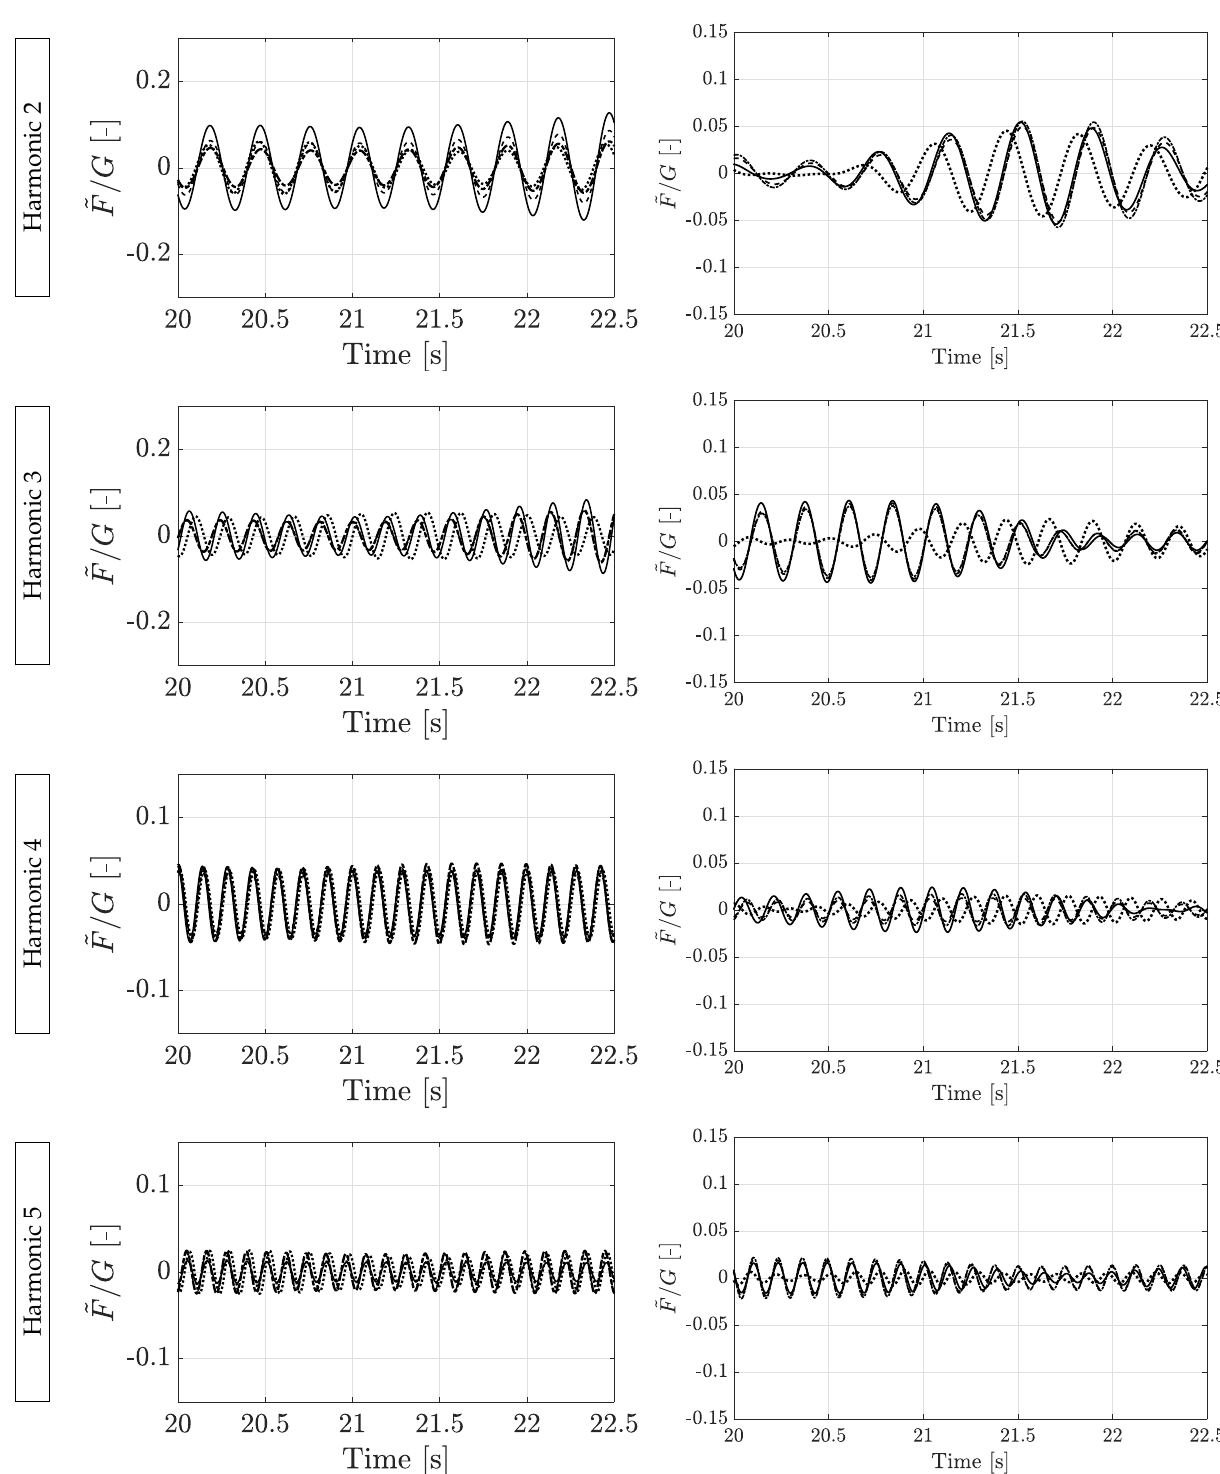
Figure 12. Relevant zoom of the time series of the contact force of the reference trial for the different harmonic components: measured (solid line) and reconstructed contact force using RM I (dashed line), RM II (dash-dotted line), and RM III (dotted